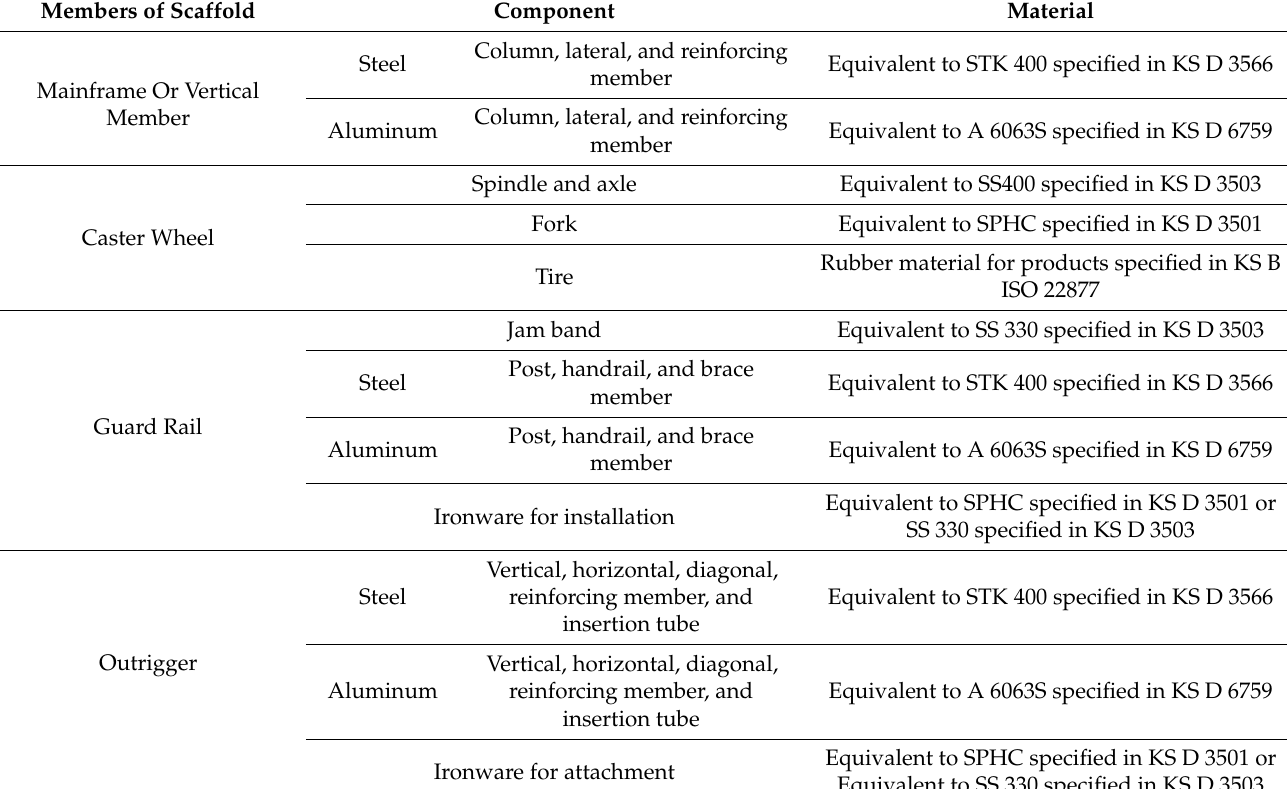
Table 14. Material standards for fabricated mobile